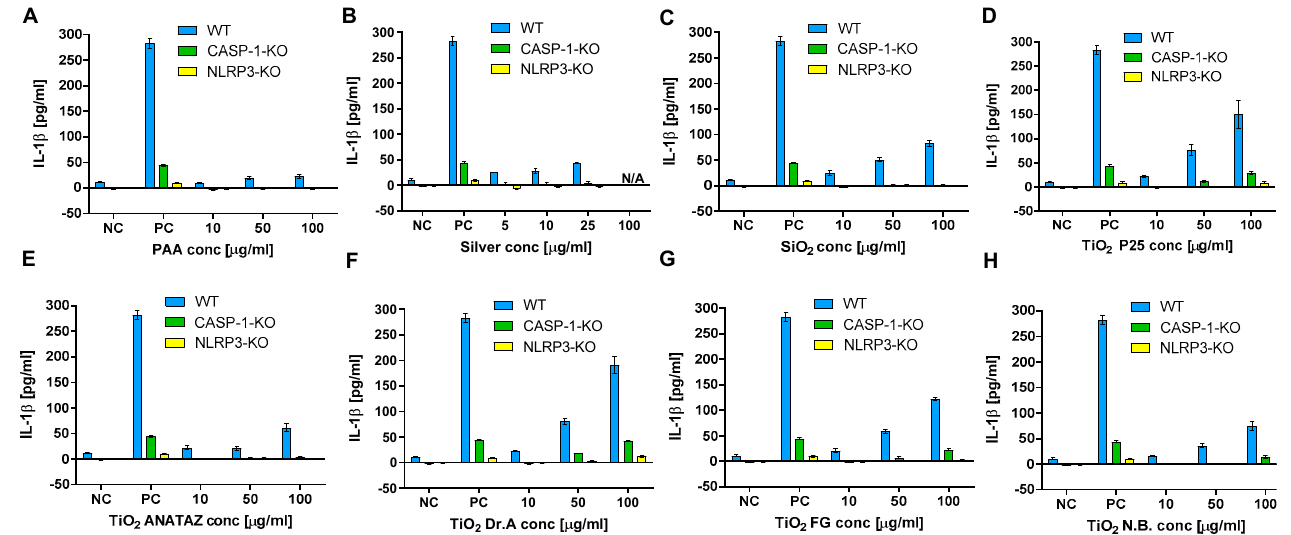
Figure 8. IL-1 β secretion in THP-1 macrophages following 18 h incubation with increasing concentration of ( A ) PAA coated NPs, ( B ) silver NPs, ( C ) engineered SiO 2 NPs ( D ) TiO 2 P25 NPs, ( E ) TiO 2 ANATAZ NPs, ( F ) TiO 2 DrA NPs, ( G ) TiO 2 food-grade (FG) NPs and ( H ) TiO 2 N.B. NPs as determined with ELISA. THP-1 macrophages were primed with LPS for 4 h, after which exposure to NPs was performed. A concentration of 200 µg mL − 1 crystalline SiO 2 NPs was used as a positive control. Please note, that lower concentrations were used for silver NPs due to excessive cell death. Representative experiment of the two experiments is shown. Mean and standard error of three replicates of the same biological repeat are shown.